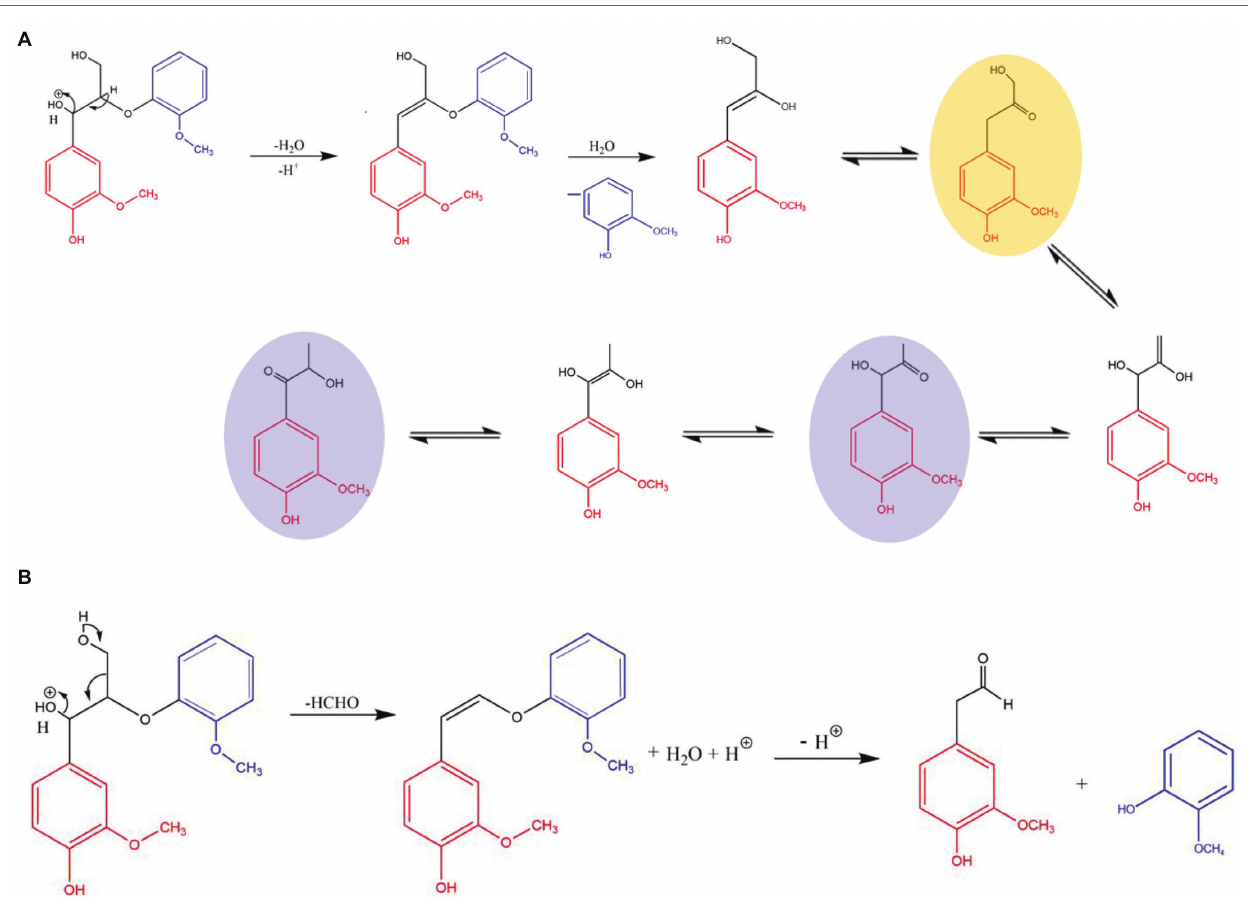
FIGURE 1 | The main reaction mechanism in acid catalyzed organic solvent pretreatment. (A) β -O-4 linkages cleavage to form ω -guaiacylacetone (yellow) and then Hibbert’s ketones (purple). (B) The cleavage of β -O-4 linkages and the elimination of